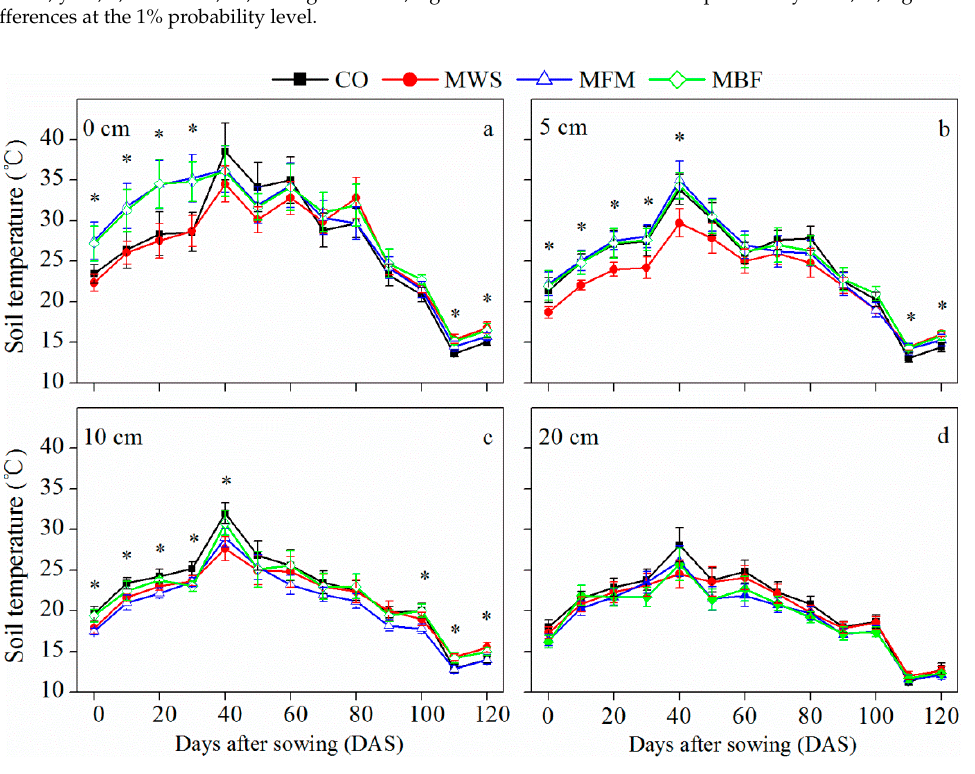
Figure 2. Effects of the treatments on average soil temperatures at indicated depths during the summer maize-growing seasons in 2014 and 2015. CO, mineral fertilizer without organic maize-growing seasons in 2014 and 2015. CO, mineral fertilizer without organic amendments; MWS, amendments; MWS, mineral fertilizer with wheat straw; MFM, mineral fertilizer with farmyard mineral fertilizer with wheat straw; MFM, mineral fertilizer with farmyard manure; MBF, mineral manure; MBF, mineral fertilizer with bioorganic fertilizer. *, p < 0.05. fertilizer with bioorganic fertilizer. *, p <